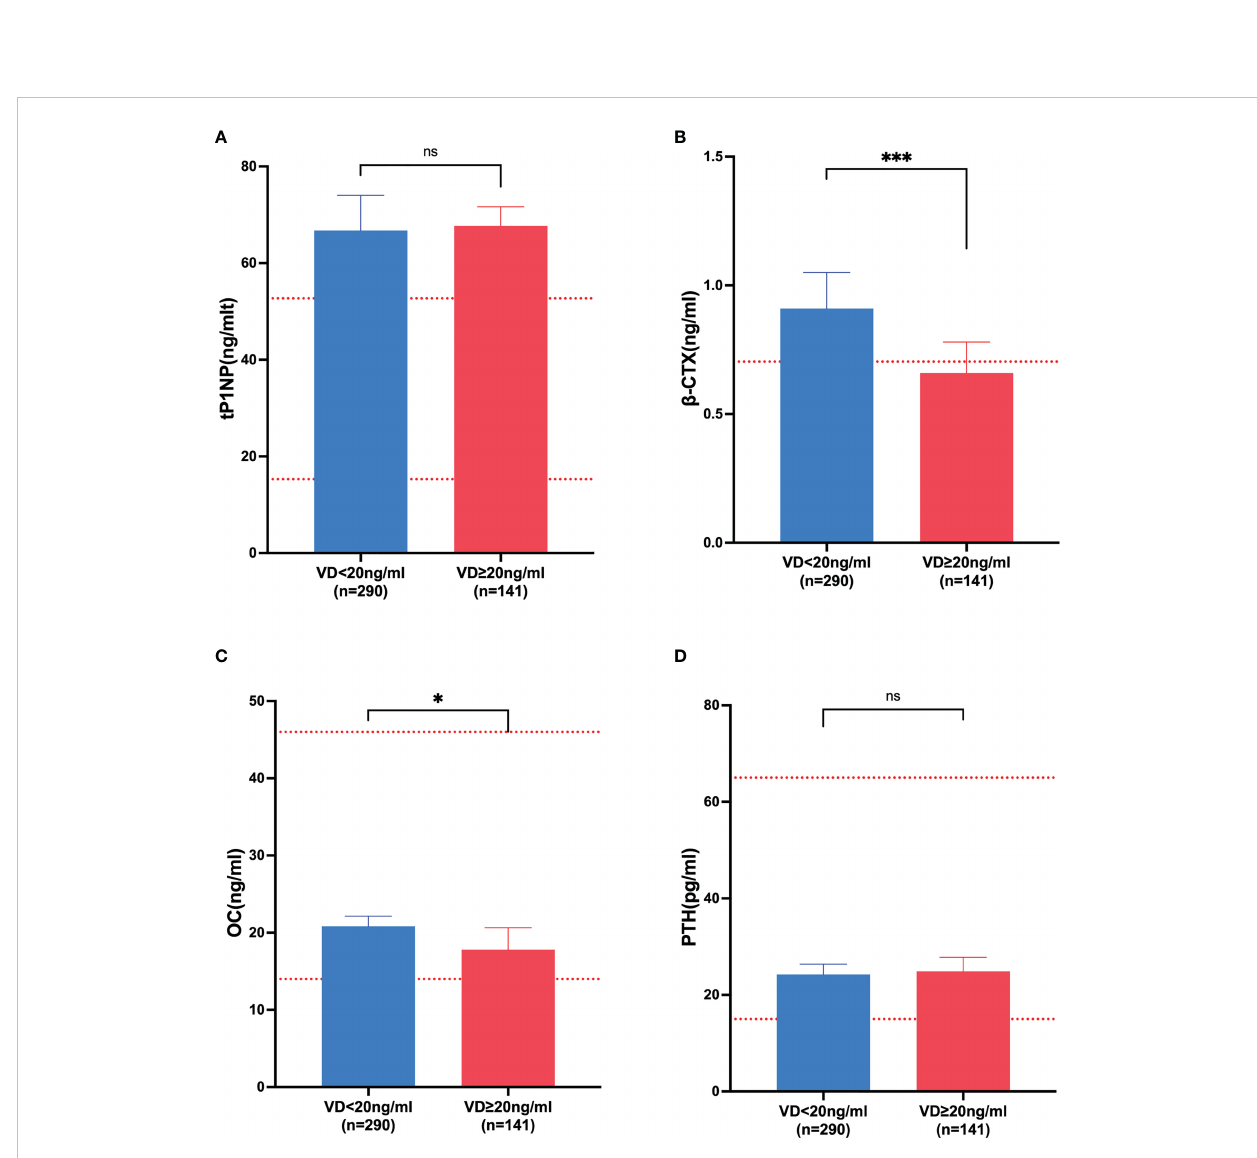
FIGURE 3 The markers of bone metabolism affected by vitamin D. (A) tP1NP; (B) b -CTX; (C) OC; (D) PTH. VD, vitamin D; tP1NP, type 1 procollagen amino- terminal propeptide; b -CTX, bone resorption C-terminal telopeptides; OC, osteocalcin; PTH, parathyroid hormone. * represented p -value ≤ 0.05; *** represented p -value < 0.0001; ns represented p -value